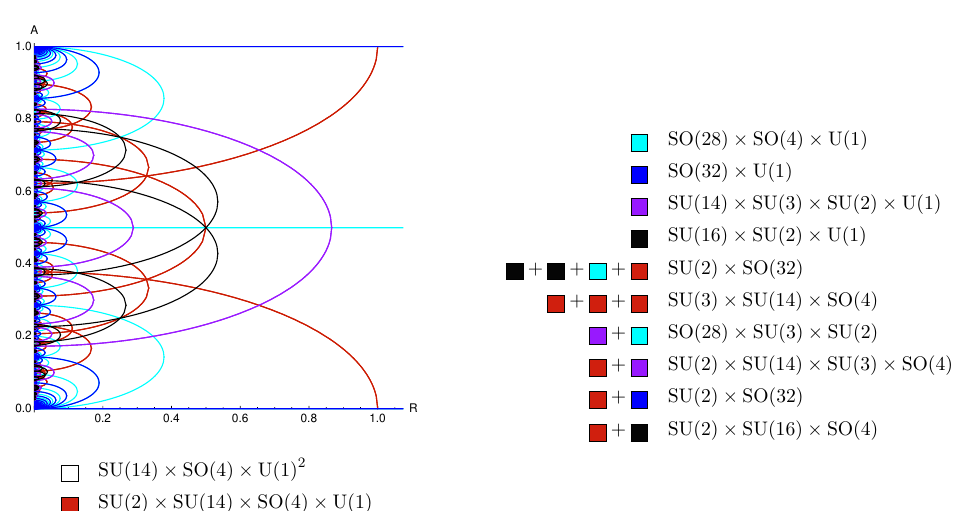
Figure 21. SO(32) heterotic with Wilson line A I = (( A ) 14 ; 0 2 ).